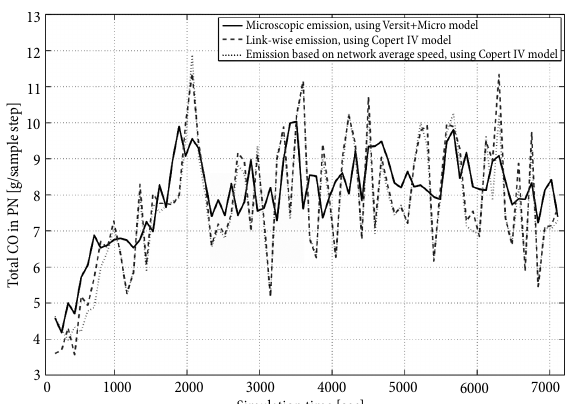
Fig. 7. Scenario 1: network